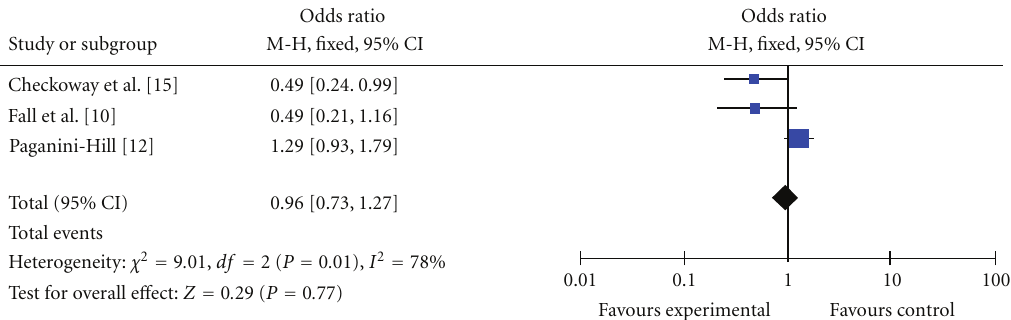
Figure 4: Pooled estimate of OR and 95% CI of PD risk for tea drinking of > 1 cups per day. Blue diamonds indicate adjusted OR in each study. Open diamonds are pooled OR. Horizontal line represents 95% CI. Studies are ordered by alphabetical order of the last name of first